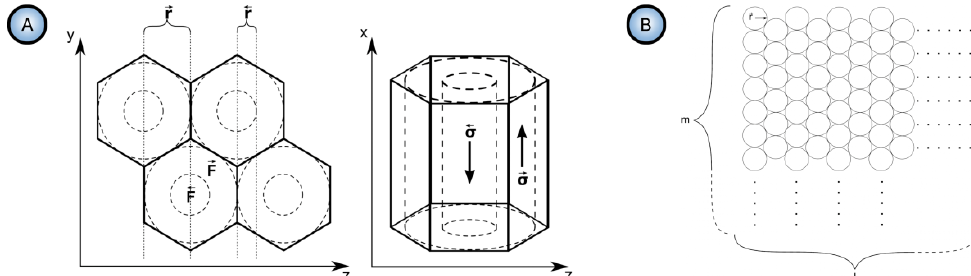
Figure 31. The geometry of an individual PAA cell ( A ), and the hexagonal PAA lattice resulting from the densest packing of ideal equal-sized circles on the anode surface ( B ), which appear in the model from Ref. [150] as initially set parameters. Reproduced with permission. Copyright 2020 American Chemical society.